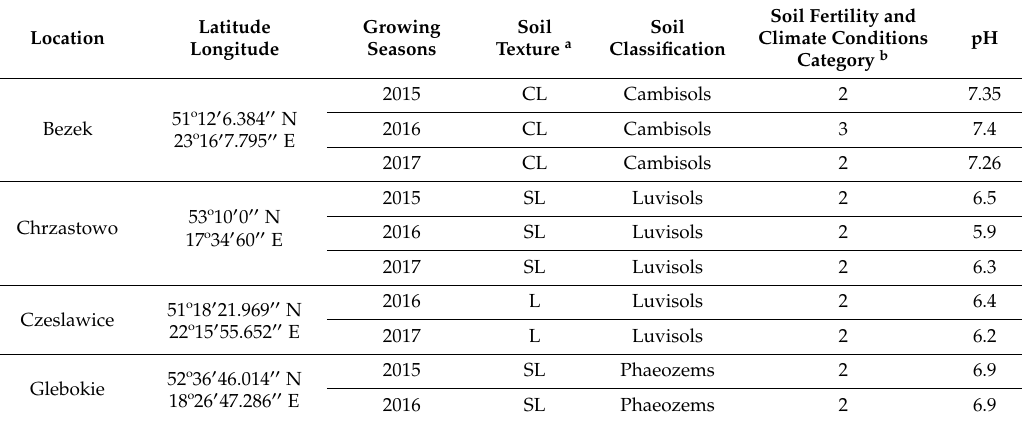
Table 1. Description of 11 trial locations in the Polish Post-Registration Variety Testing System within three growing